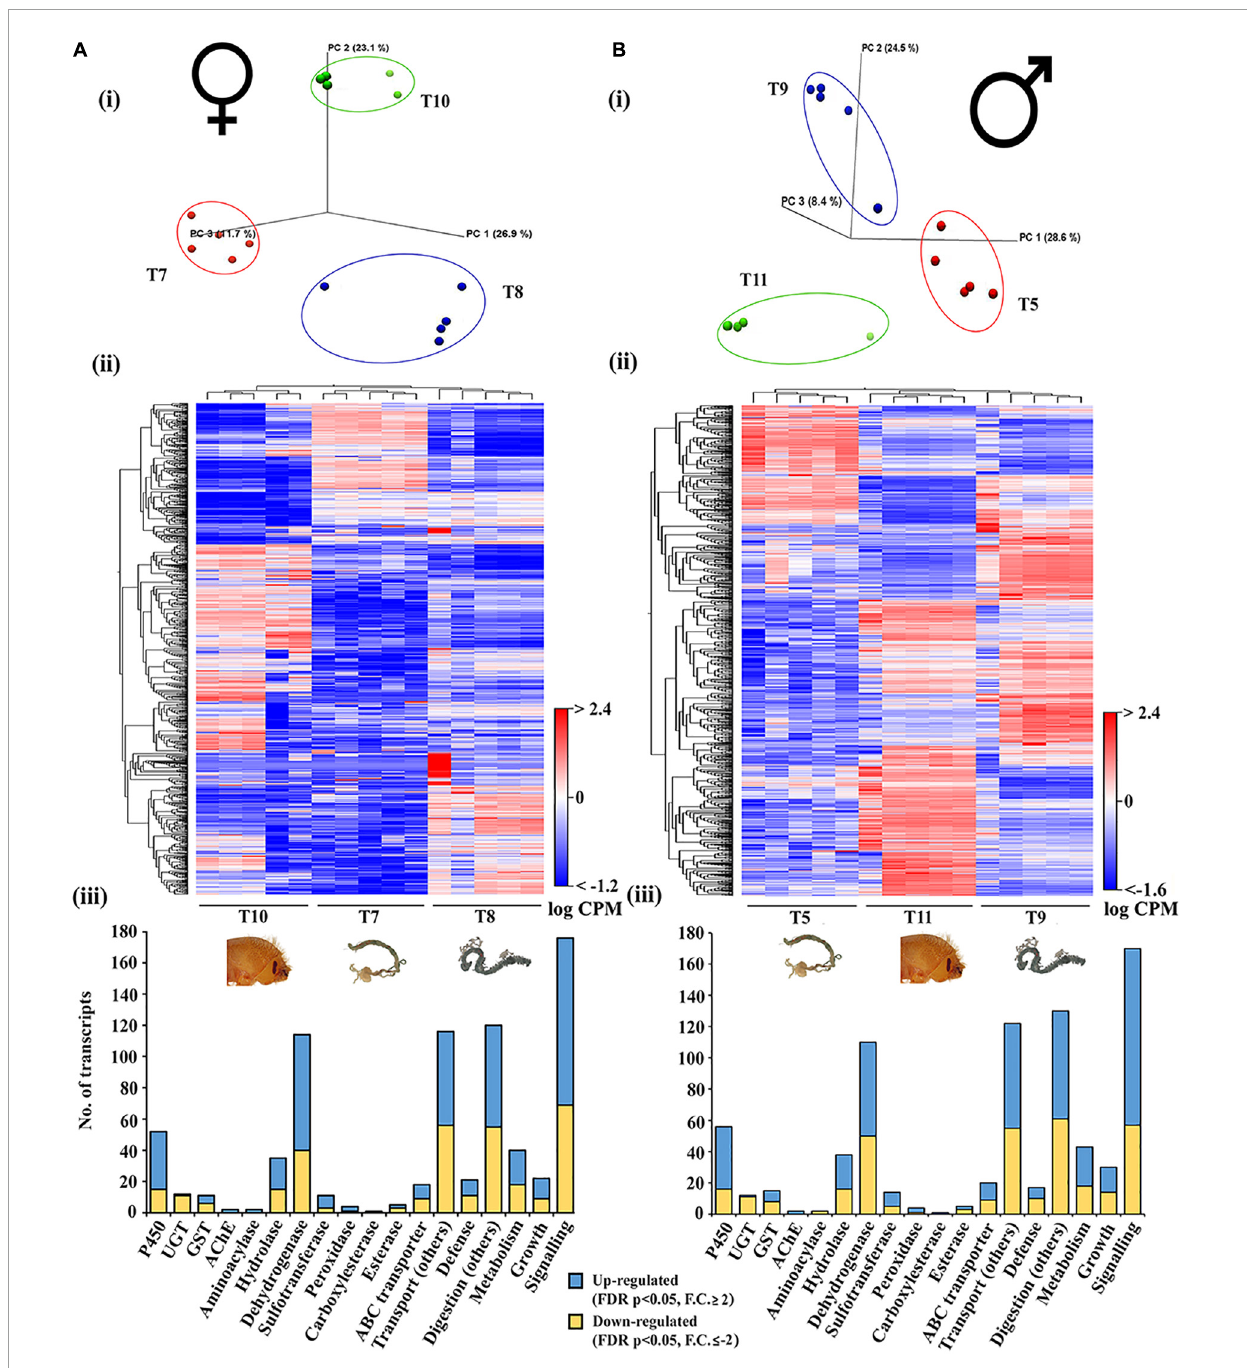
FIGURE7 Tissue-specific comparison in callow male and female beetles. (A) Callow female head (T10), Callow female gut (T7), and Callow female fat body (T8) ( N = 5). (B) Callow male head (T11), Callow male gut (T5), and Callow male fat body (T9) ( N = 5). (i) PCA plots showing sample clustering. (ii) Heat maps representing gene clustering. The color spectrum, stretching from blue to red, represents TMM-adjusted log CPM expression values obtained after DGE analysis. (iii) Bar graphs showing differentially expressed contigs of detoxification-related enzyme families and other essential enzymes related to defense, digestion, transport, metabolism, signaling, and growth after group-wise comparison between different developmental life stages. Analysis was done using the CLC workbench using FDR p < 0.05 and fold change ± 2 as cut-offs for significance.